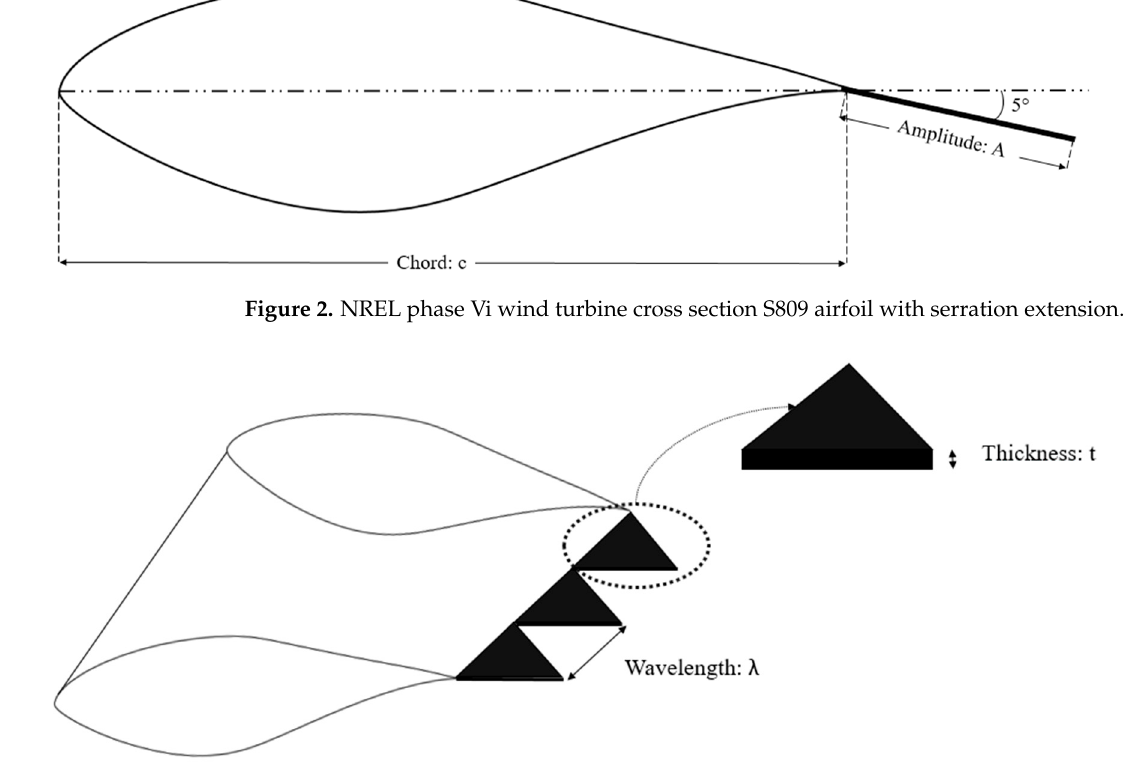
Figure 3. Trailing edge serration representation over a section of the NREL phase VI wind turbine.